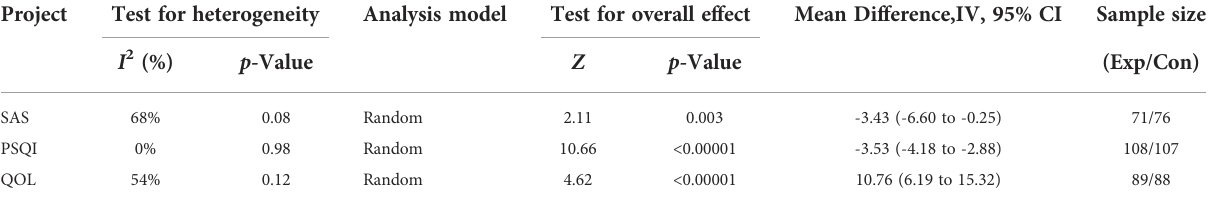
TABLE 2 Quality of Life Questionnaire-Core 30 scale.